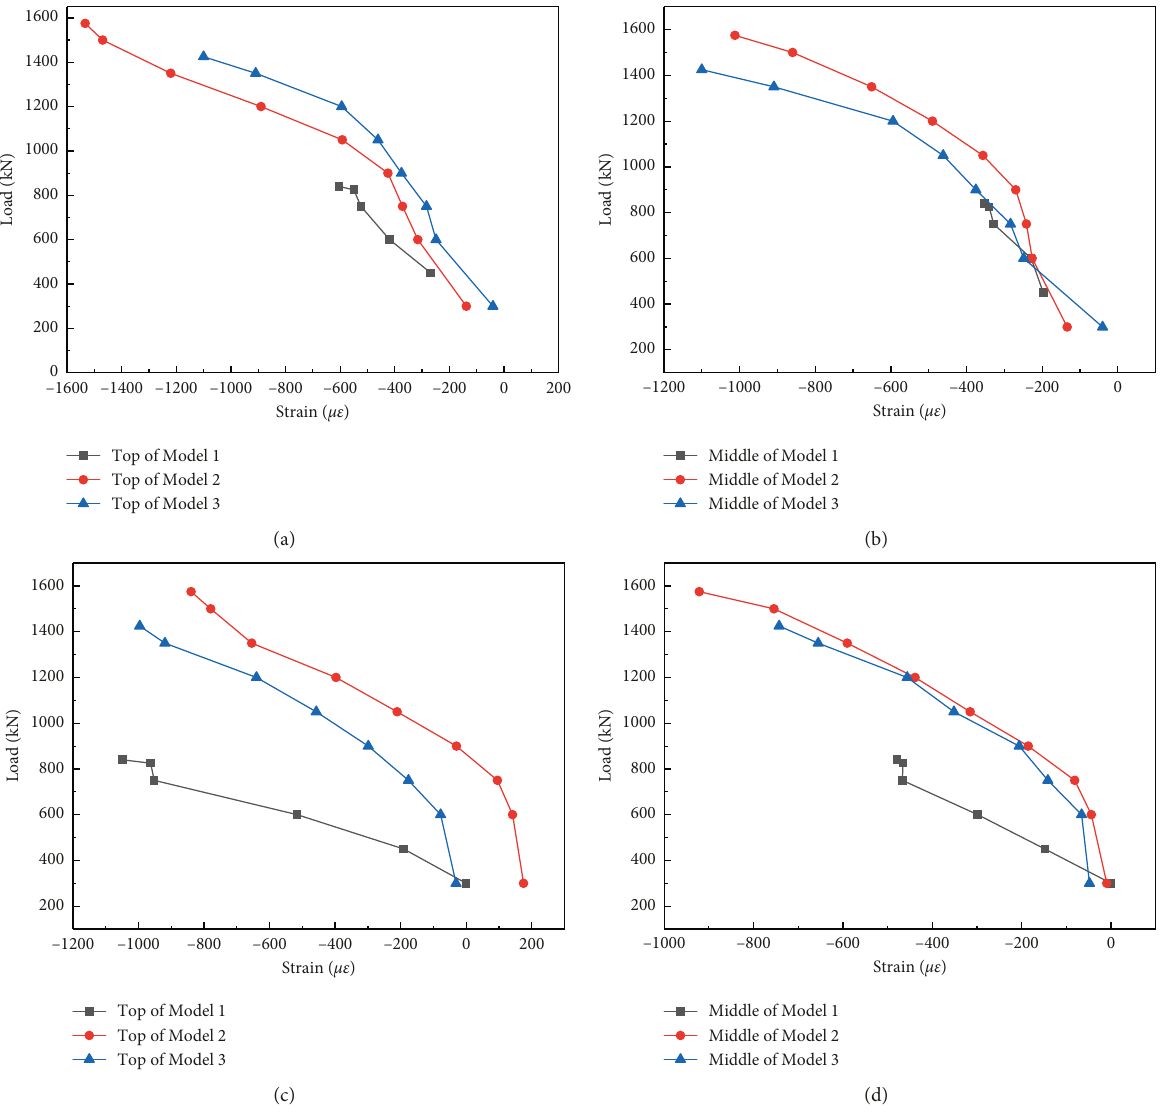
Figure 24: Comparison of load-strain curves of vertical rod in Models 1, 2, and 3. (a) Top of A3 rod. (b) Middle of A3 rod. (c) Top of C3 rod. (d) Middle of C3